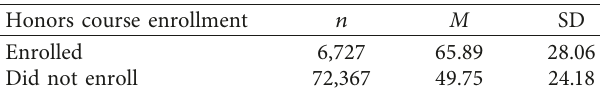
Table 1: Descriptive statistics for active and collaborative learning benchmark scores by honors course enrollment